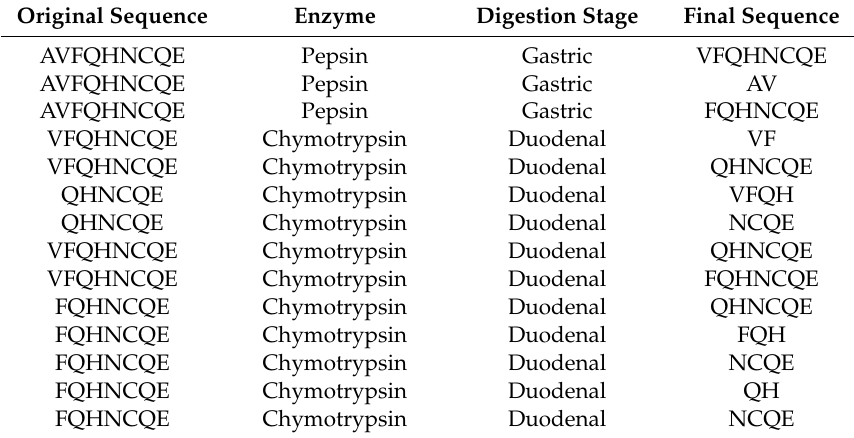
Table 1. In silico simulated digestion of the peptide